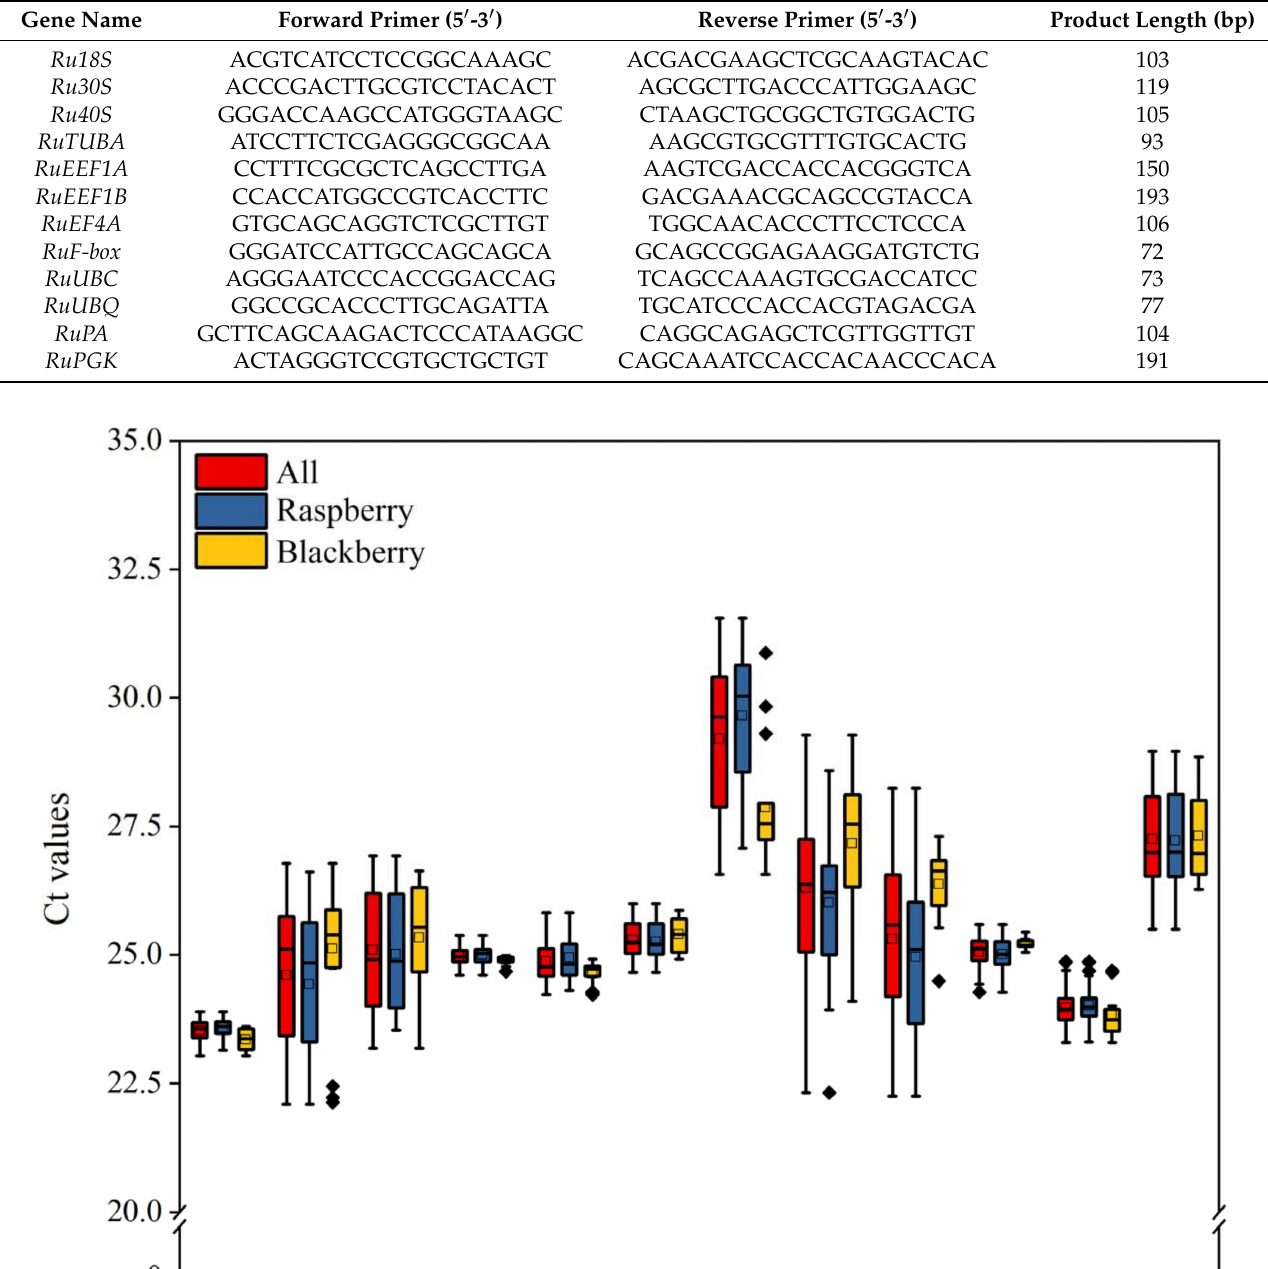
Table 1. Primer sequences of candidate reference genes.